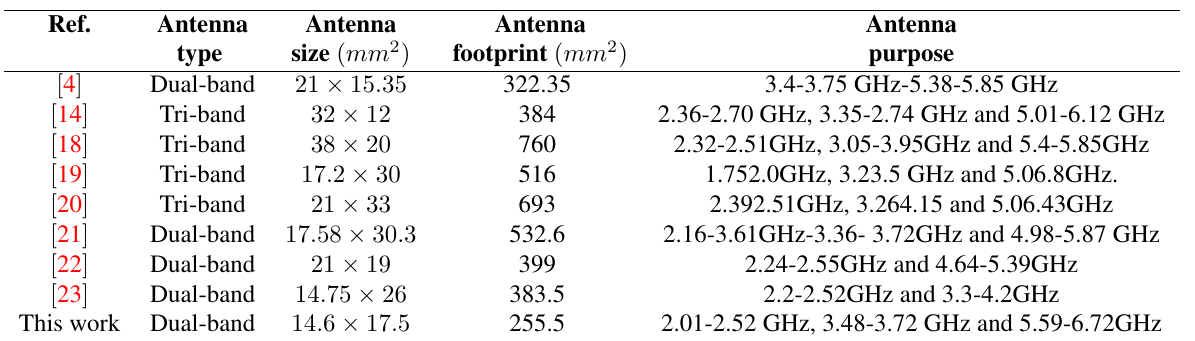
Table 2: Comparison between proposed antenna size along with applications bands with other compact antennas